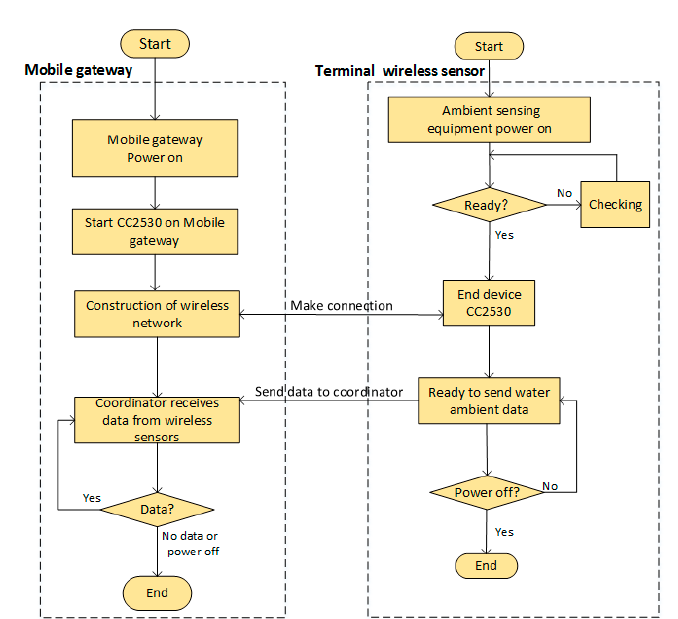
Figure 6. The flow chart of ambient observation and wireless communication for live transportation.